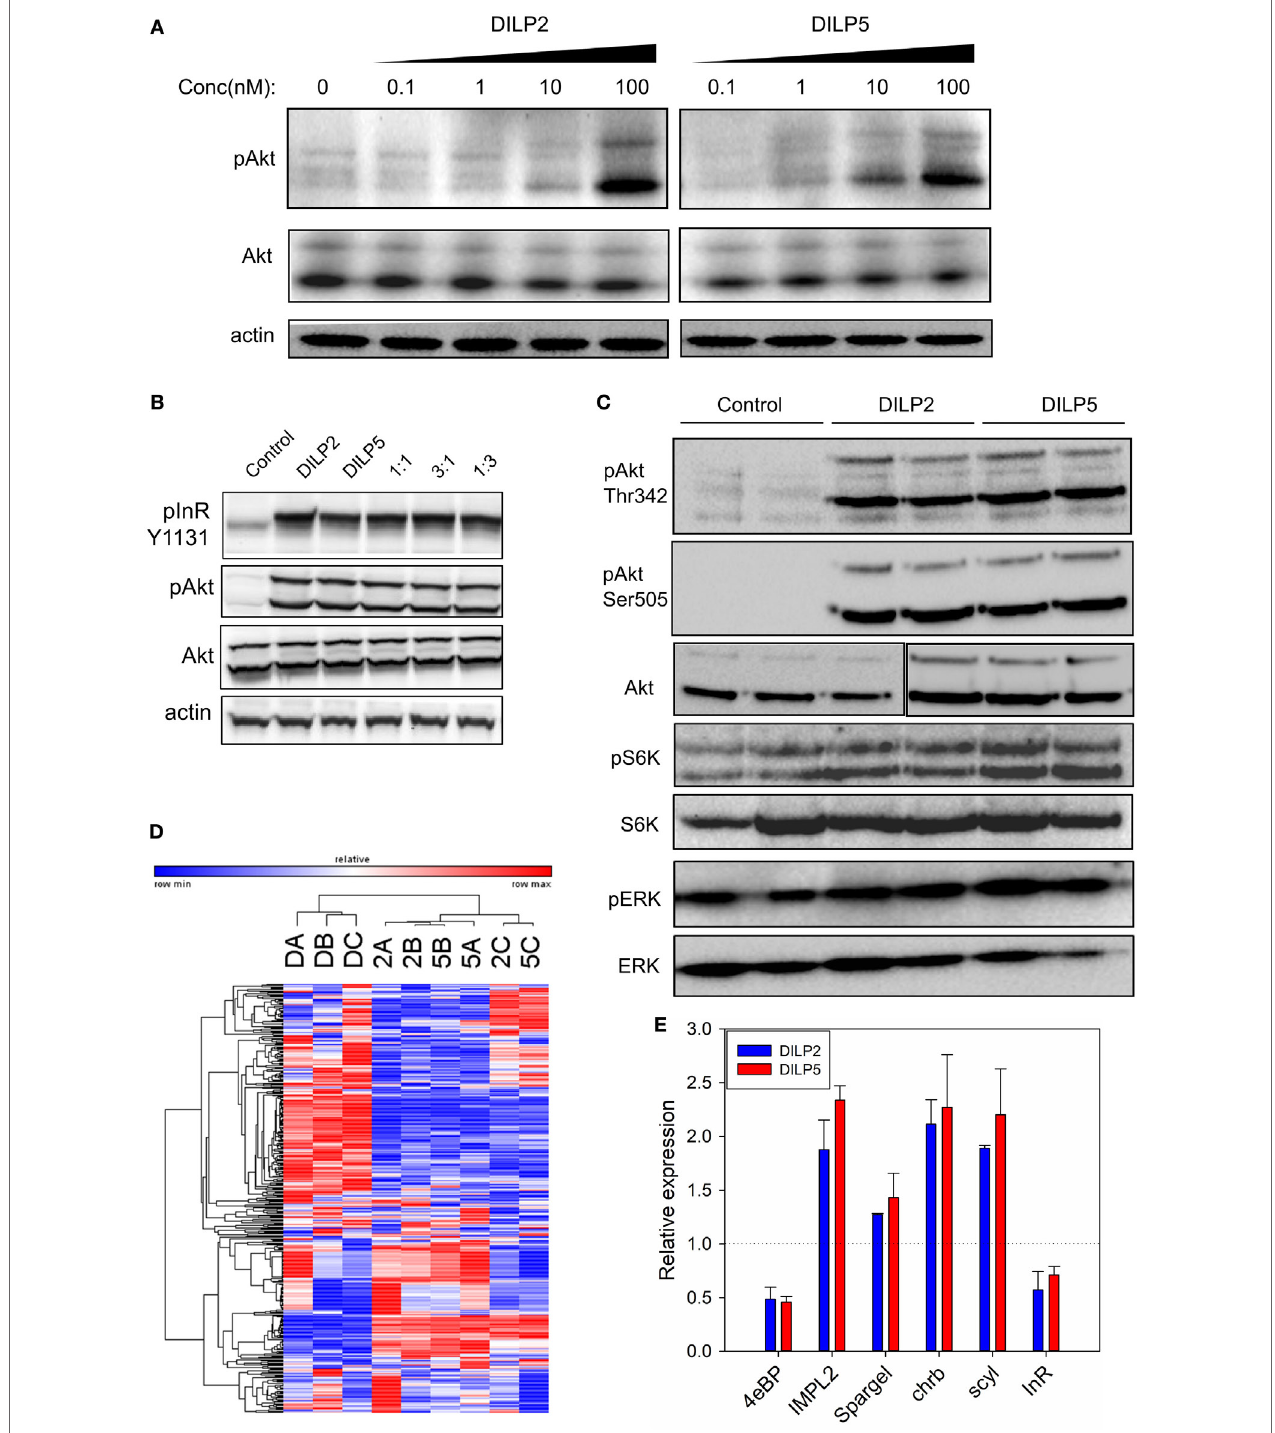
FigUre 2 | Drosophila insulin-like peptide (DILP) 2 and DILP5 induce similar signaling in S2 cells. (a) DILP2 and DILP5 stimulate Akt phosphorylation with comparable potency. S2 cells were stimulated with DILP2 or DILP5 for 5 min at the specified concentrations. (B) DILP2 and DILP5 activate InR and Akt the same in competition assays, inducing similar phosphorylation each alone, with equal parts each ligand or, with an excess of one ligand. S2 cells stimulated for 5 min with DILP2 or DILP5 at 100 nM, with 50 nM DILP2 and 50 nM DILP5 (“1:1”), with 75 nM DILP2 and 25 nM DILP5 (“1:3”), and with 25 nM DILP2 and 75 nM DILP5 (“1:3”). (c) DILP2 and DILP5 similarly stimulate pAkt, pS6K, and pERK at 100 nM for 5 min. (D) DILP2 and DILP5 at 100 nM for 1 h induce similar gene expression profiles. Heatmap represents the transcript RPKM values with the top 2.5% coefficient of variation between samples: DILP2 (“2”), DILP5 (“5”), or control serum- depletion (“D”). (e) DILP2 and DILP5 at 100 nM for 1 h induce similar changes in gene expression measured by qPCR.